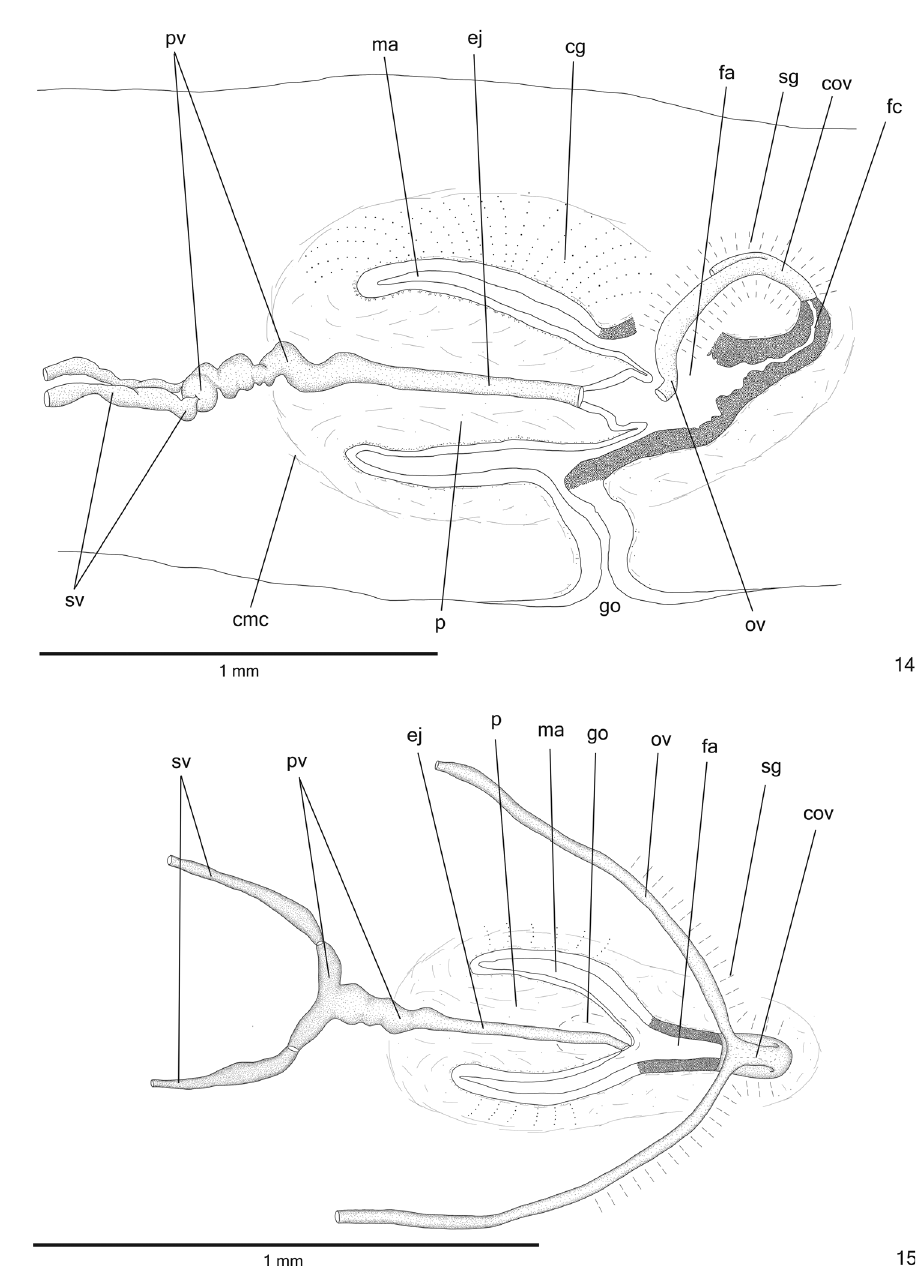
Figures 14–15. Cratera cryptolineata sp. n., 14 holotype, sagittal composite reconstruction of copulatory apparatus 15 specimen MZU PL.00219, horizontal composite reconstruction of copulatory